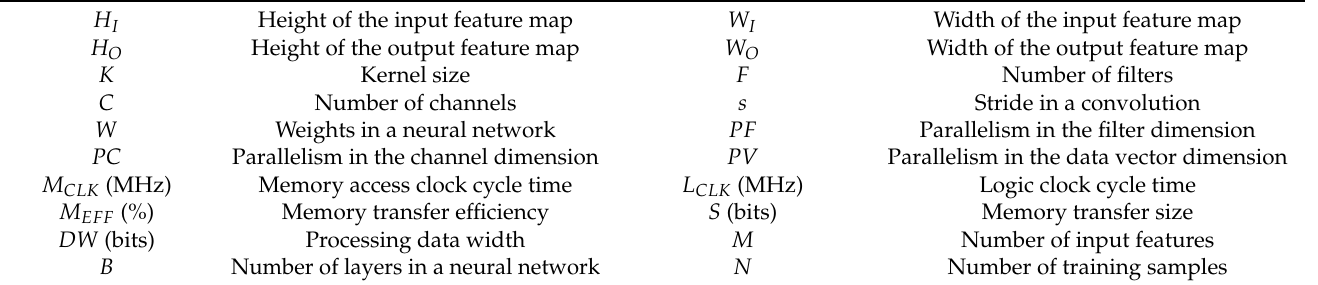
Table 1. Notation used in this